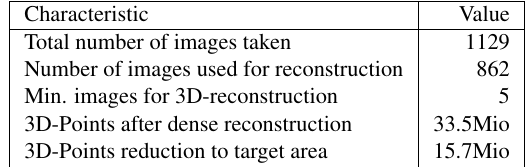
Table 1: Summary of the structure from motion reconstruction.